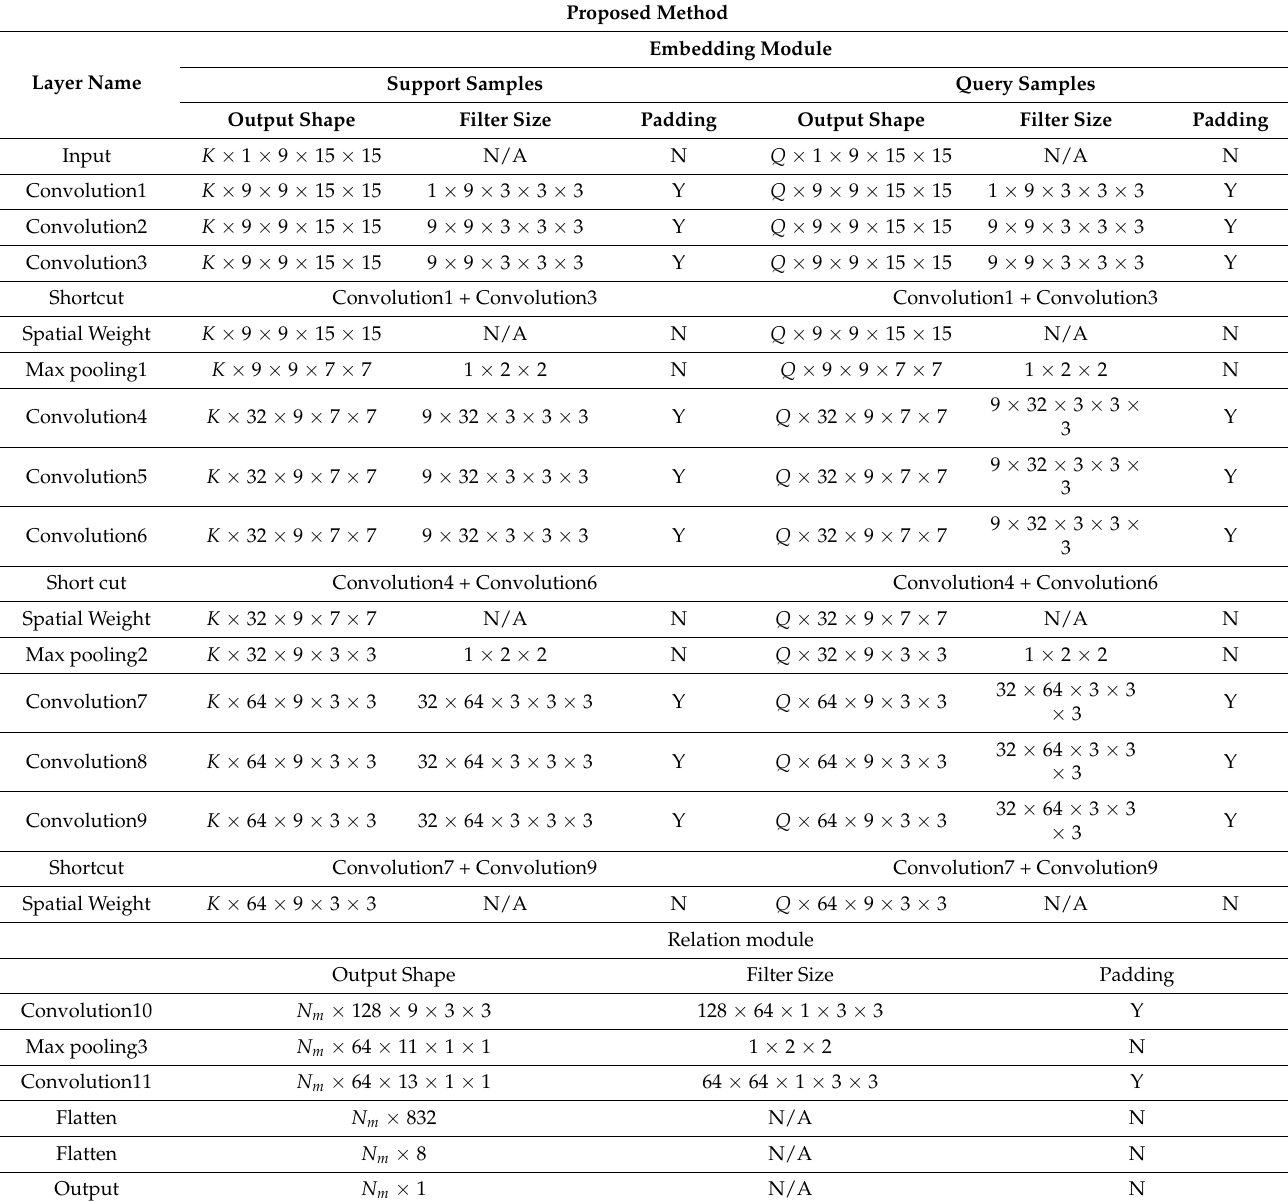
Table 2. The specific parameters of the proposed classification